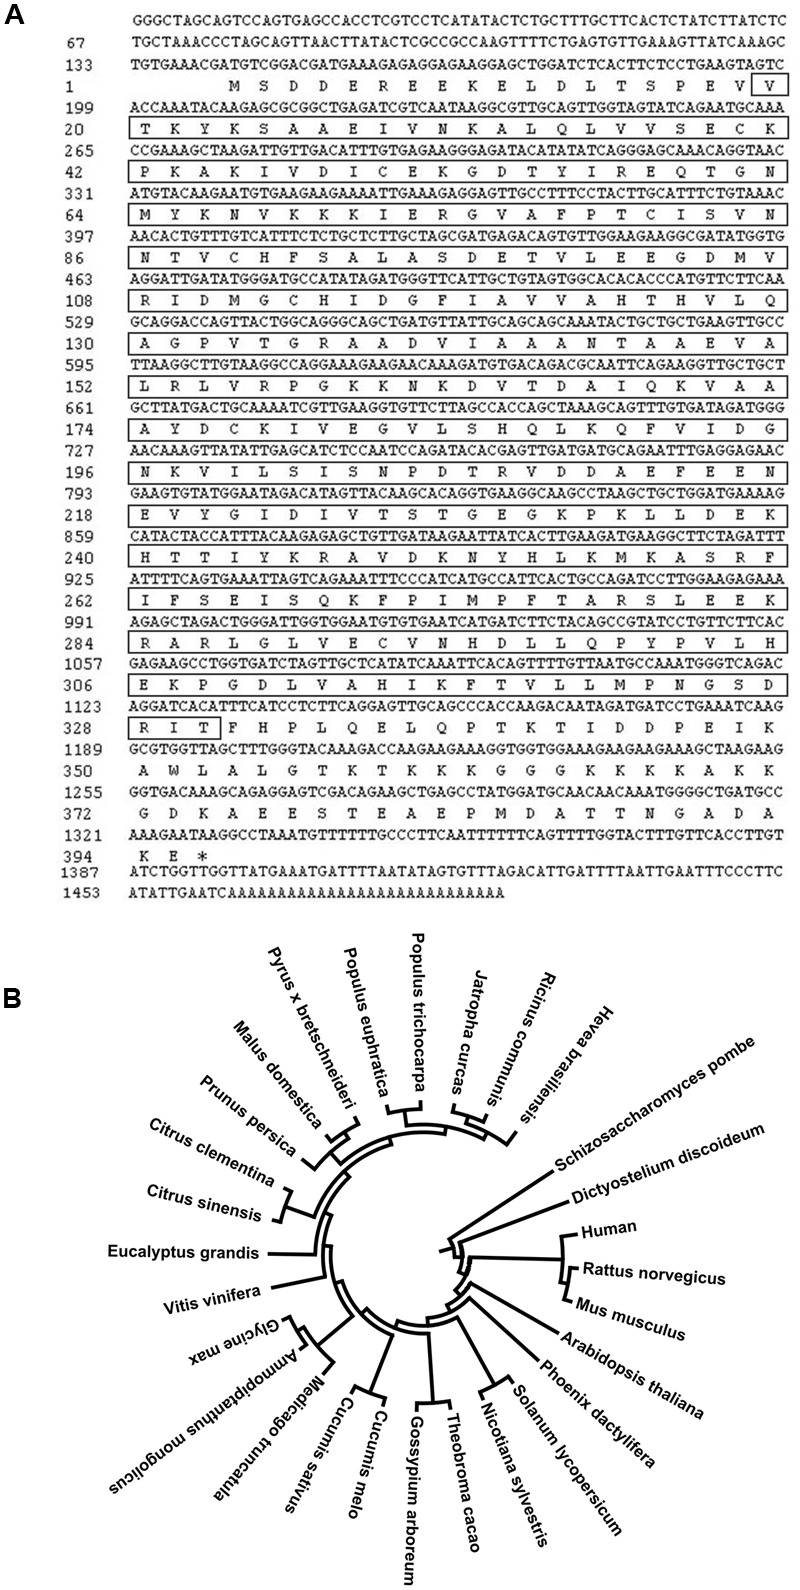
(A) Full-length cDNA sequence of rubber tree ErbB-3 binding protein 1 (HbEBP1) and its deduced encoding peptide. The sequence in the square frame corresponds to the deduced MAP domain. (B) Phylogenetic tree showing similarity of the deduced H. brasiliensis EBP1 protein sequence with EBP1s from other plant species. EBP1 peptide sequences of each species were downloaded from GenBank based on the following accession numbers: Ricinus communis, XP_002530504.1; Jatropha curcas, XP_012089820.1; Populus trichocarpa, XP_002308228.2; Populus euphratica, XP_011046861.1; Pyrus × bretschneideri, XP_009376423.1; Malus domestica, XP_008362268.1; Prunus persica, XP_007205303.1; Citrus clementina, XP_006429434.1; Citrus sinensis, KDO56711.1; Eucalyptus grandis, XP_010037691.1; Vitis vinifera, XP_002262986.2; Glycine max, XP_003529167.1; Ammopiptanthus mongolicus, ABF66654.1; Medicago truncatula, XP_003623305.1; Cucumis melo, XP_008442393.1; Cucumis sativus, XP_004137704.1; Gossypium arboreum, KHG25370.1; Theobroma cacao, XP_007026646.1; Nicotiana sylvestris, XP_009789408.1; Solanum lycopersicum, XP_004242516.1; Phoenix dactylifera, XP_008805004.1; Arabidopsis thaliana, Q96327.1; Mus musculus, P50580.3; Rattus norvegicus, Q6AYD3.1; Homo sapiens, Q9UQ80.3; Dictyostelium discoideum, Q1ZXG4.1; Schizosaccharomyces pombe, Q09184.1. The phylogenetic tree was constructed using a MEGA 6.06 software.